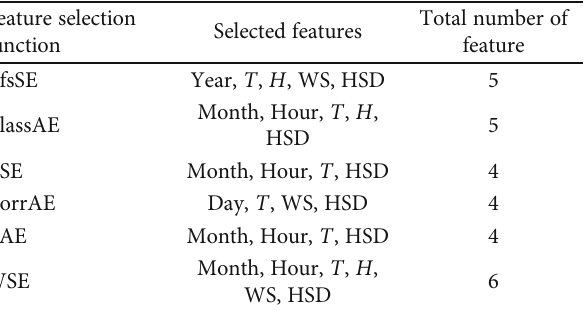
Table 6: Input features a ff ecting the SR the most in